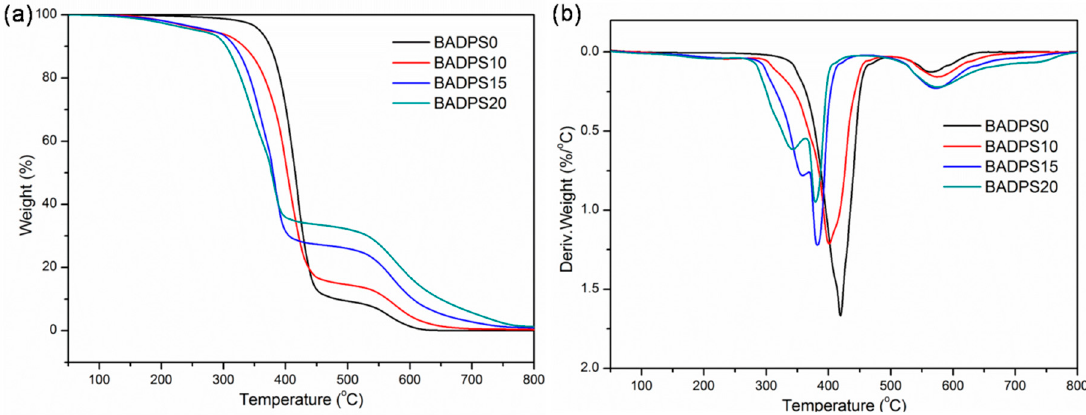
Figure 5. ( a ) TG and ( b ) DTG curves of the different UPRs in air. Table 2. Glass transition temperature ( T g ) and thermogravimetric analysis (TGA) data in air and N 2 atmospheres for the different UPRs.